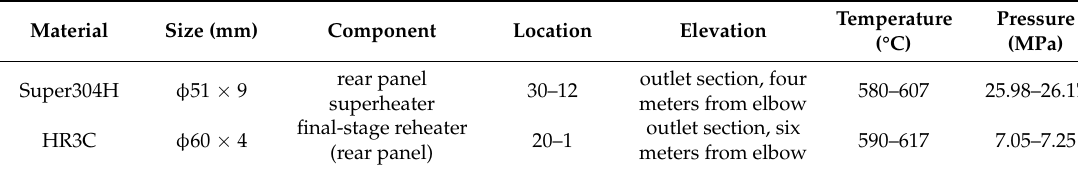
Table 2. Operational parameters of Super304H and HR3C tubes.